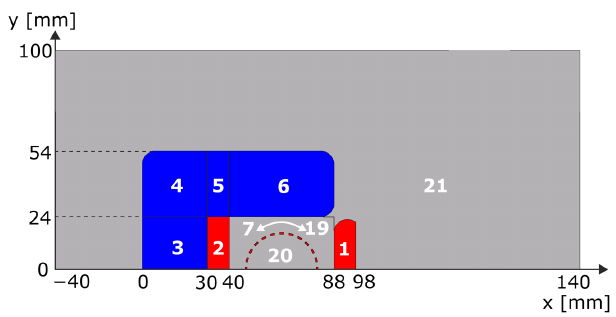
FIG. 13. Geometry of the kicker magnet with a beam screen (Opera-2D model). Due to the top-bottom symmetry only the upper half is modeled. The individual regions are